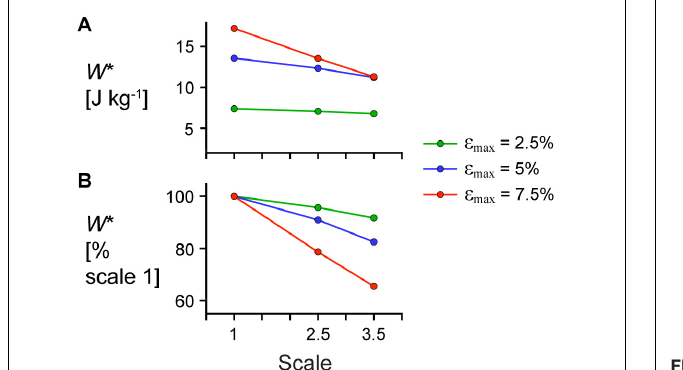
FIGURE 7 | Effect of cycle strain amplitude on the relationship between scale and mass-specific mechanical work. (A) Absolute mass-specific mechanical work per cycle W * across scales (muscle sizes) for different maximum strain amplitudes ε max and (B) W * as a percentage W * for scale 1 simulations at the same ε max . All W * results are for simulations with a maximum relative excitation of 1, initial pennation angle β 0 of 15.3 ◦ , and 2 Hz cycle frequency. Note that the lines connecting discrete points are intended to aid in visualization rather than to imply a linear relationship.